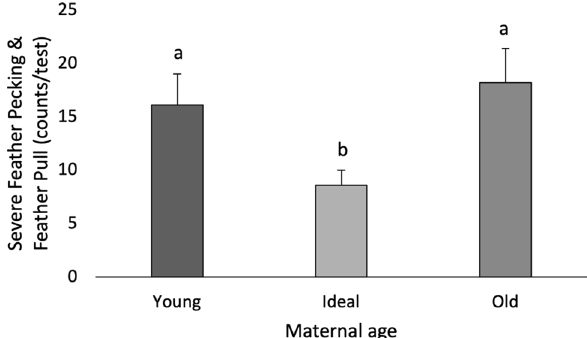
Figure 4. Social feather pecking test. Number of severe feather pecking and feather pulling displayed by maternal age.